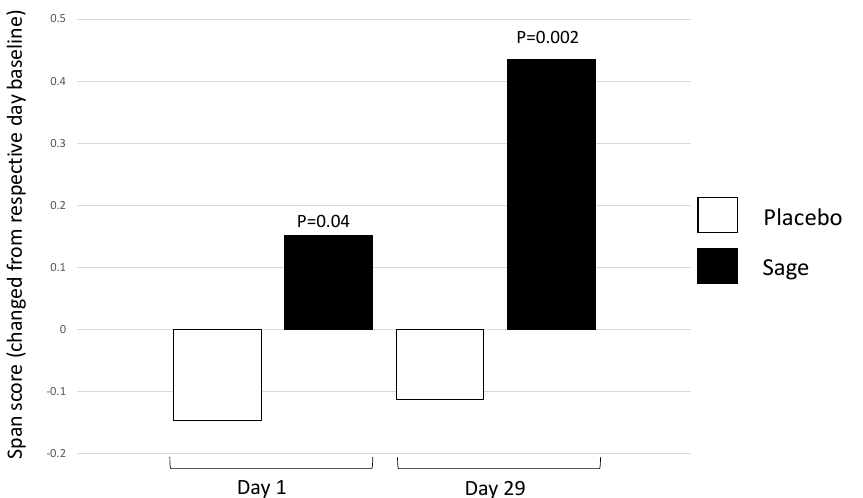
Figure 5. Acute effect of treatment on Corsi blocks span score on day 1 and day 29: a significant main acute effect of treatment was observed on both day 1 ( p = 0.04) and day 29 ( p = 0.002) when post-dose performance was compared to the pre-dose performance on the same day.